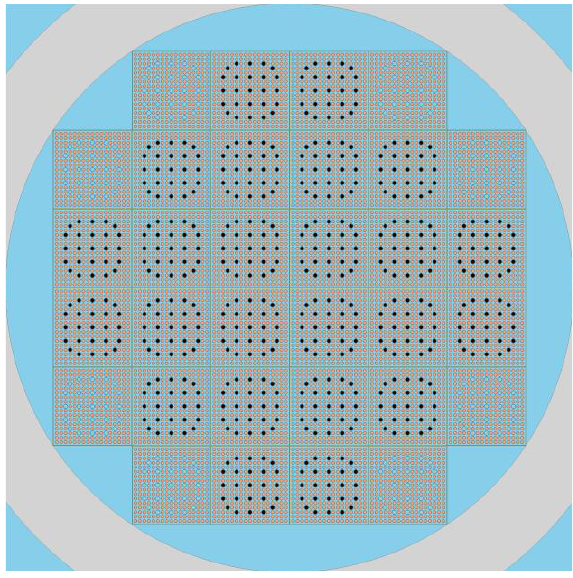
Figure 10. Proposed GBC-32 cask design